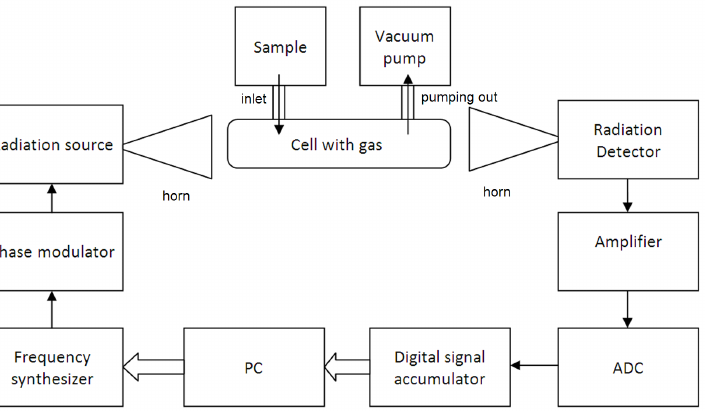
Figure 1. The scheme of a phase switching spectrometer, where PC is a personal computer and ADC is an analogue-to-digital converter.